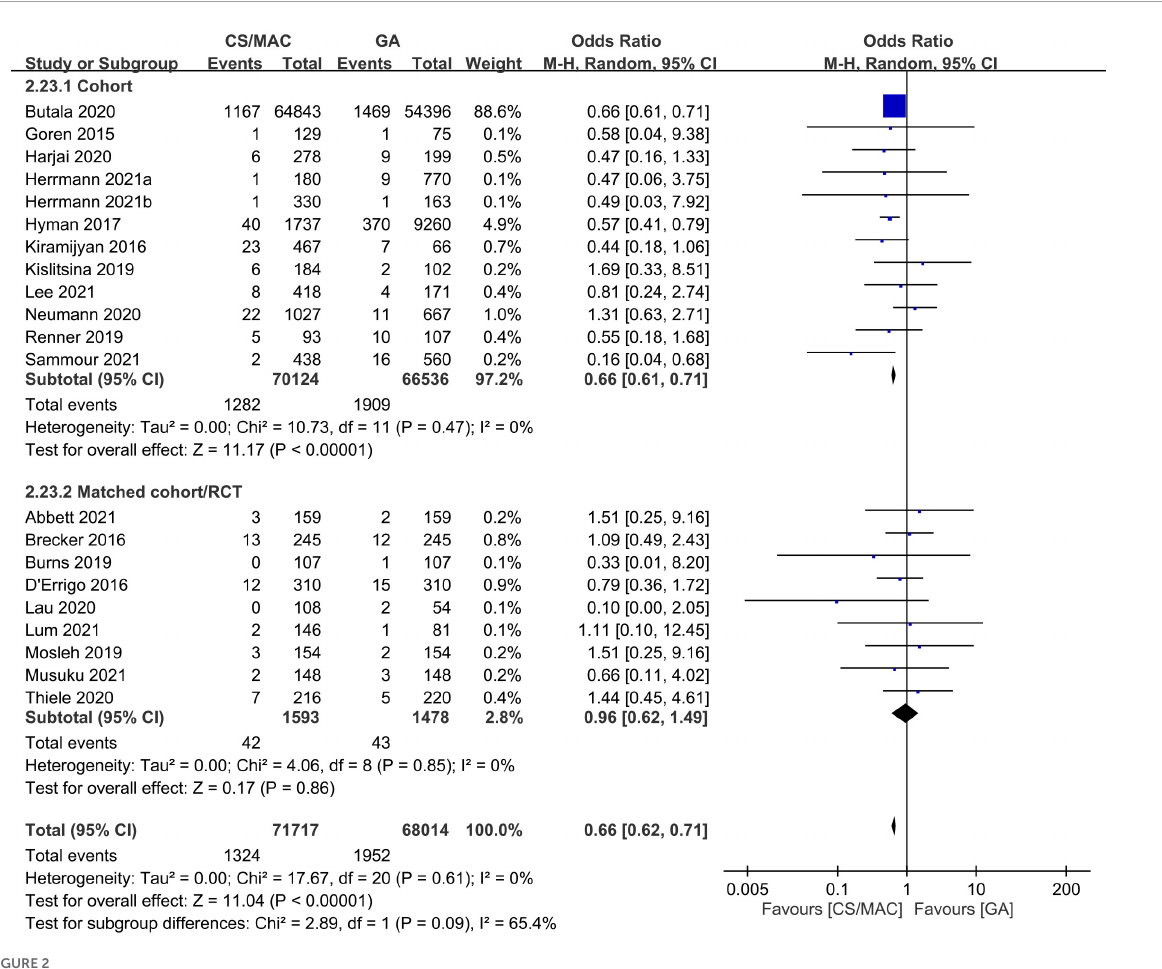
FIGURE2 Forest plot comparing the risk of 30-day mortality between patients receiving conscious sedation/monitored anesthesia care (CS/MAC) and those undergoing general anesthesia (GA). CI, confidence interval; M-H, Mantel-Haenszel.